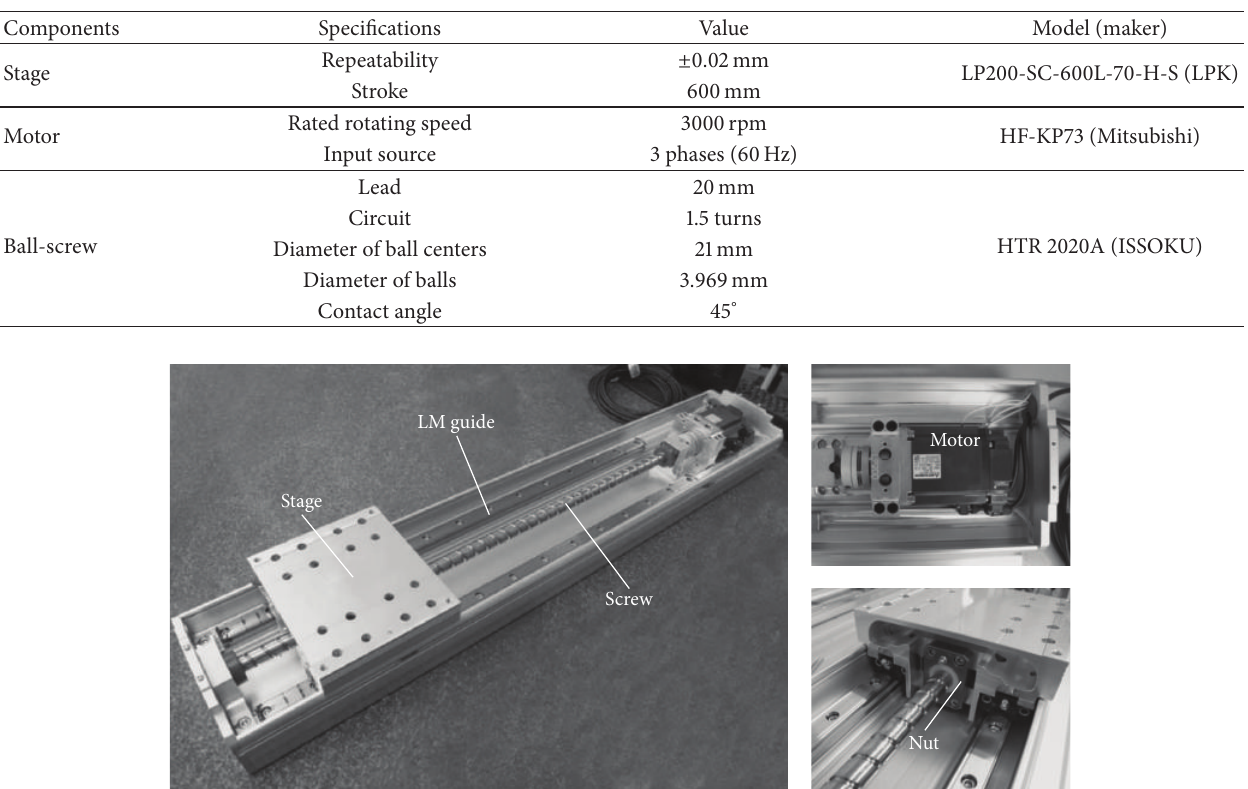
Table 1: Specifications of ball-screw-driven stage.